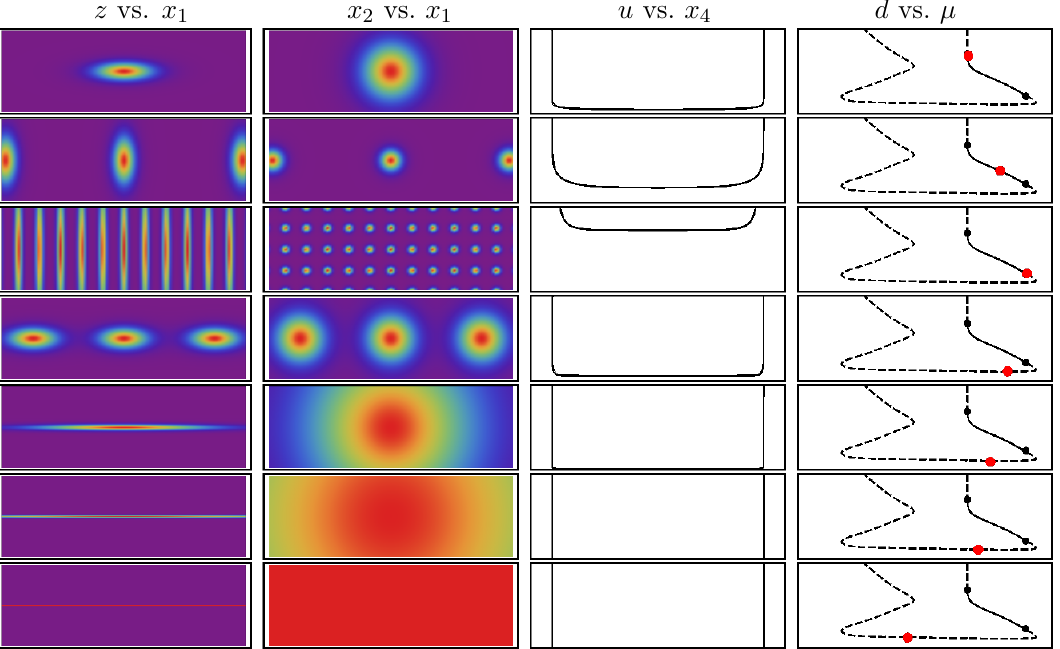
Figure 4 . First column: instanton pro(cid:12)les cut along the z - x 1 plane at x 2 = x 3 = 0, with z 2 [ (cid:0) 2 ; 2] and an x 1 range of length 2. Second column: cubic instanton lattice in the x 1 - x 2 plane at z = x 3 = 0, with an x 1 range of length 2 and x 2 range of length 2/3. Third column: embedding function of the (cid:13)avor branes, x 4 2 [ (cid:0) 0 : 6 ; 0 : 6] and u 2 [0 ; 10], showing the continuous transition from the chirally broken to the chirally restored phase. The branes are asymptotically (cid:12)xed at x 4 ( u = 1 ) = (cid:6) 1 = 2. Fourth column: same double-logarithmic plot as in the left panel of (cid:12)gure 2, with the large (red) dot indicating the ( d; (cid:22) ) values for each row and the line style distinguishing between stable (solid) and metastable or unstable (dashed)